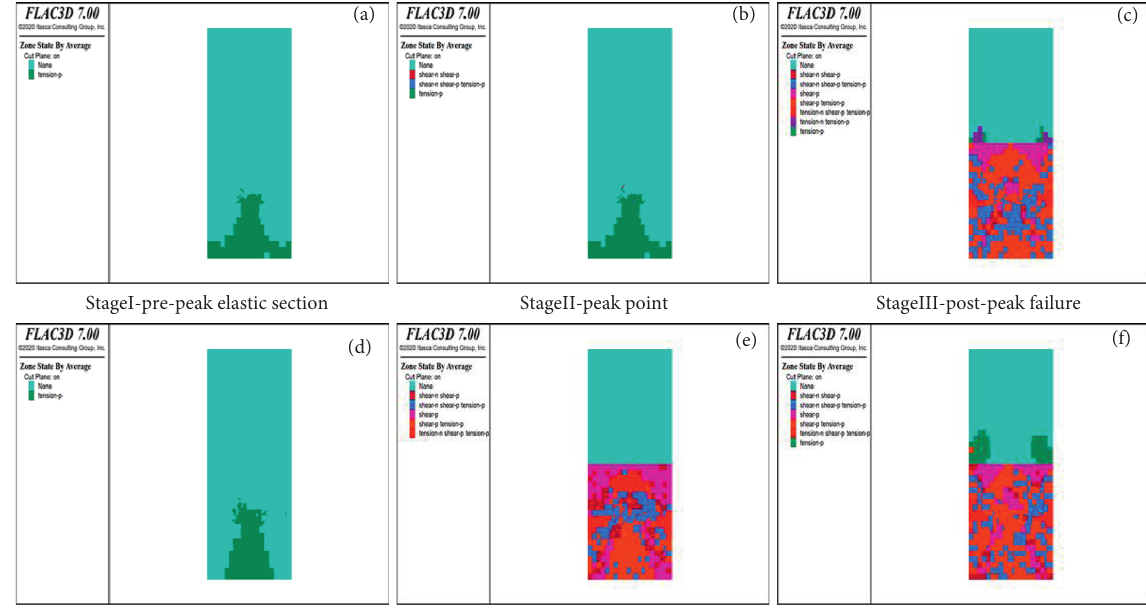
Figure 3: Distribution of the plastic zone under different